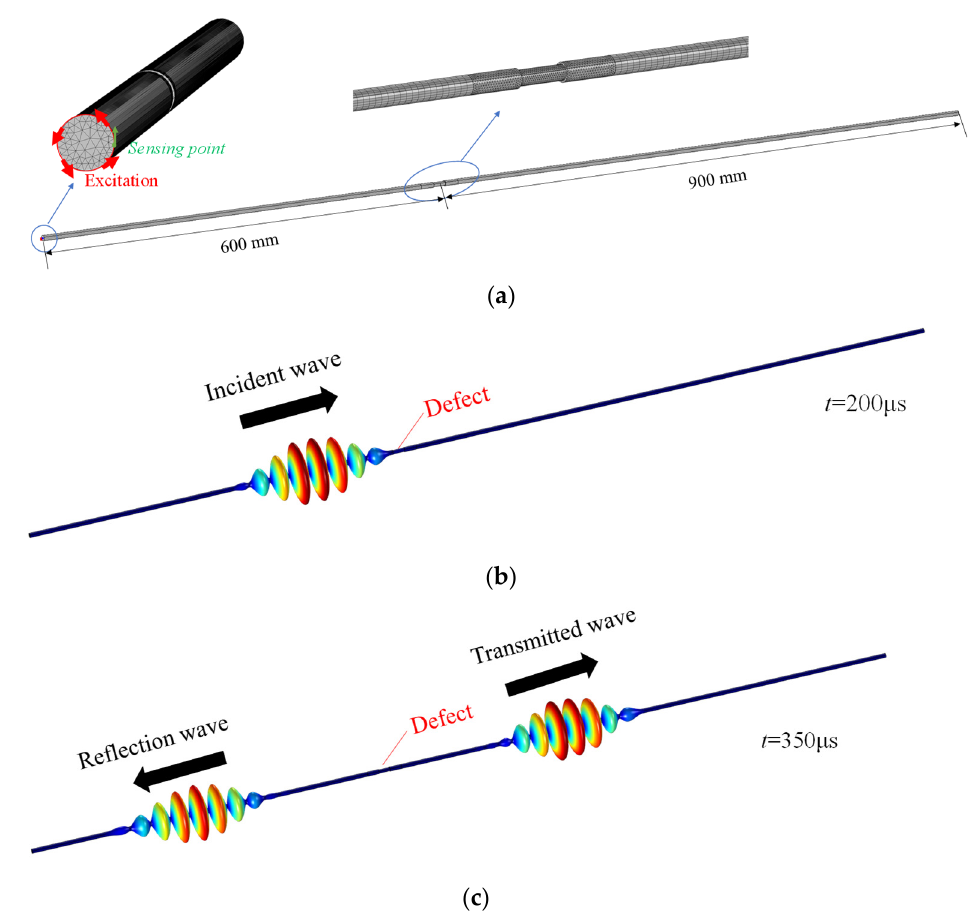
Figure 4. ( a ) Sketch of the finite element model; ( b ) the wavefield at 200 μ s; ( c ) the wavefield at 350 μ s.